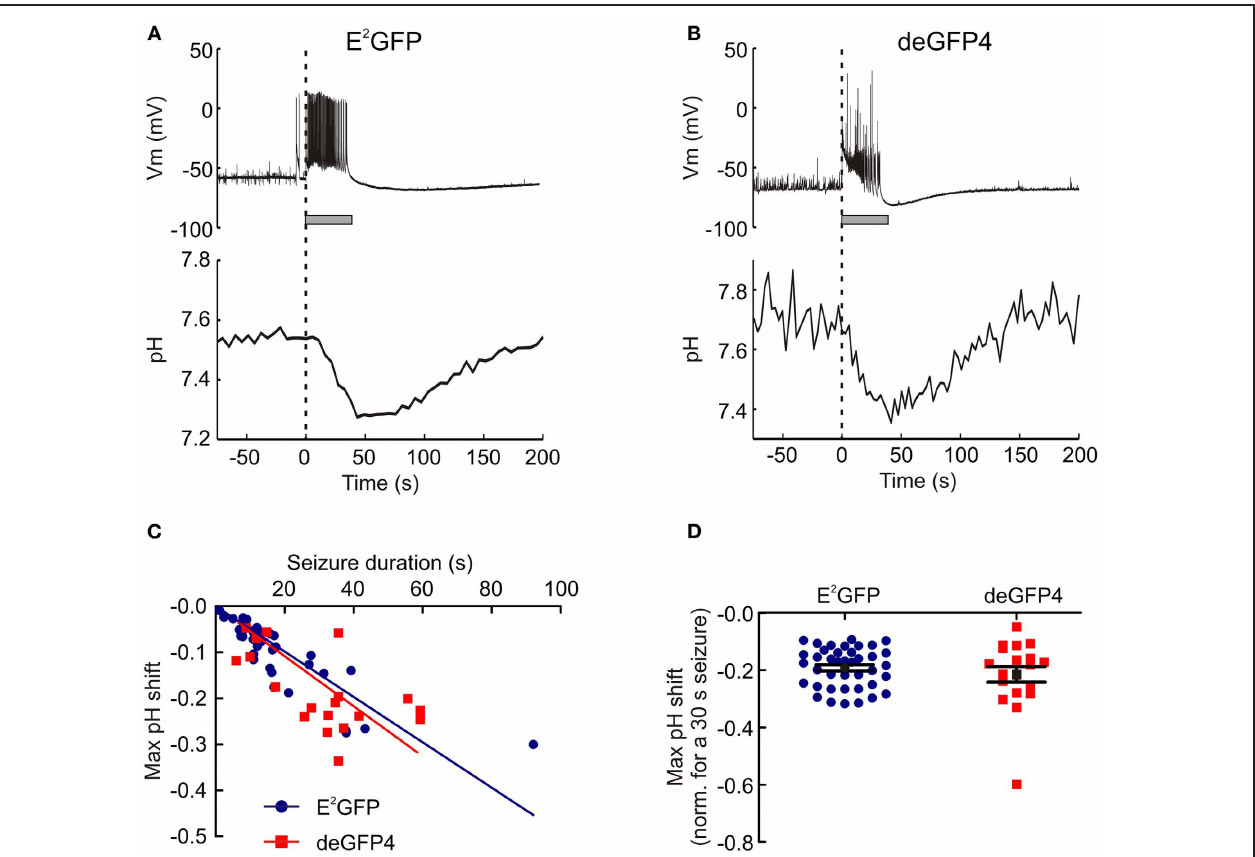
FIGURE 3 | 0Mg 2 + induced epileptiform activity induces acidic transients in neurons. (A) The intracellular pH of a hippocampal CA3 pyramidal neuron transfected with E 2 GFP recorded during an episode of 0Mg 2 + induced epileptiform activity. The onset of epileptiform activity (dashed line) is correlated with the start of a decrease in intracellular pH. The pH continues to decrease during the seizure and reaches a minimum around the time of seizure termination (seizure duration is depicted by the horizontal gray bar), and then recovers to baseline in the post-seizure period.